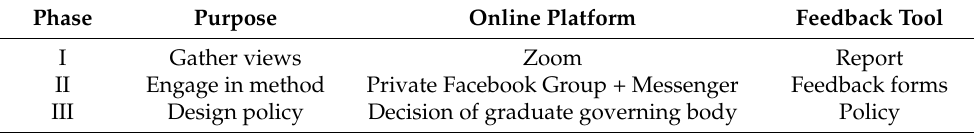
Table 3. The components for creating a new policy of graduate mentorship and supervision. These include: the purpose of the three phases for developing a new policy of graduate mentorship and supervision in relation to increases in anxiety and depression brought on by the COVID-19 pandemic, the online platform used to communicate during each phase, and the feedback tool produced to determine the results of the